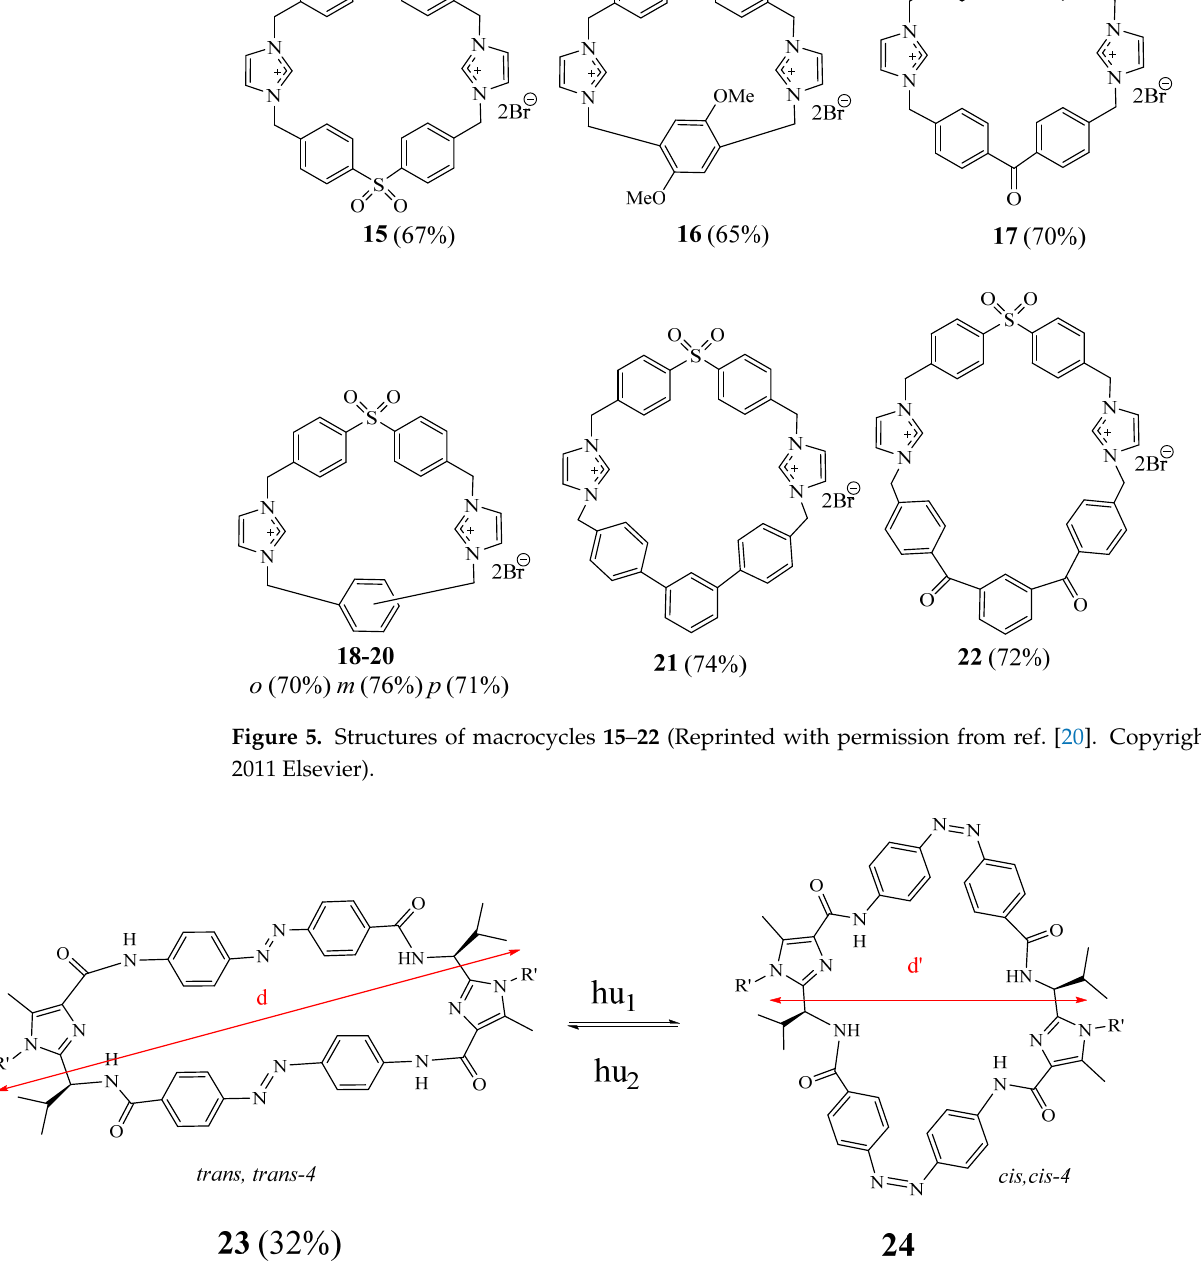
Figure 6. Structures of conformational macrocycles 23 and 24. (Reprinted with permission from ref. [21]. Copyright 2018 John Wiley and Sons).